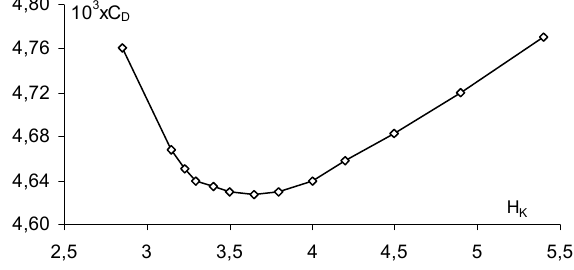
Fig 8. Calculated (MSES) drag coefficient of airfoil 1 versus shape parameter H K at the transition on the upper side at a =